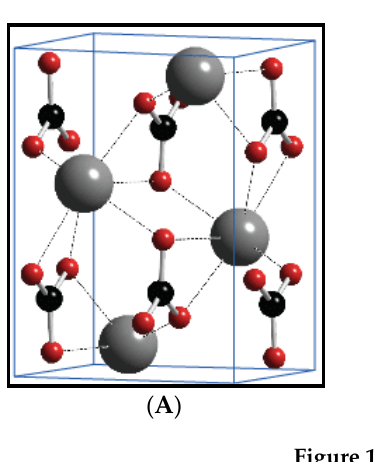
Figure 1. Image showing ( A ) calcium carbonate aragonite polymorph structures [33], ( B ) chemical structure of cellulose, and ( C ) polylactic acid [34].